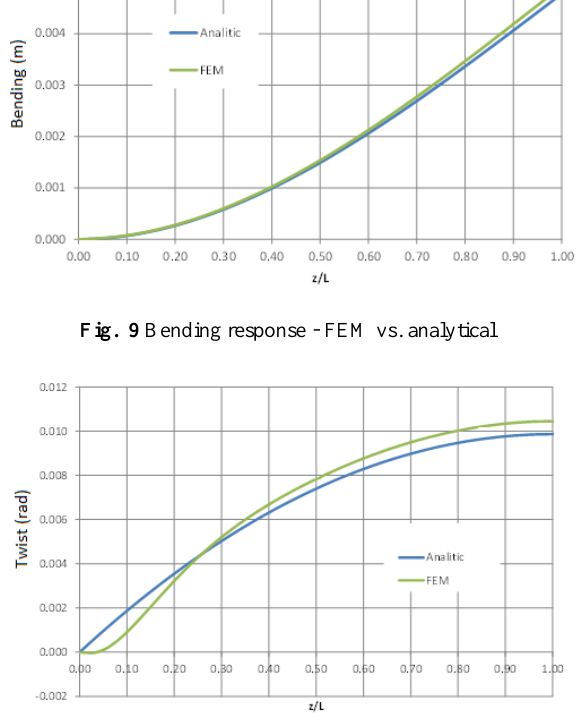
Fig. 10 Twist response - FEM vs.